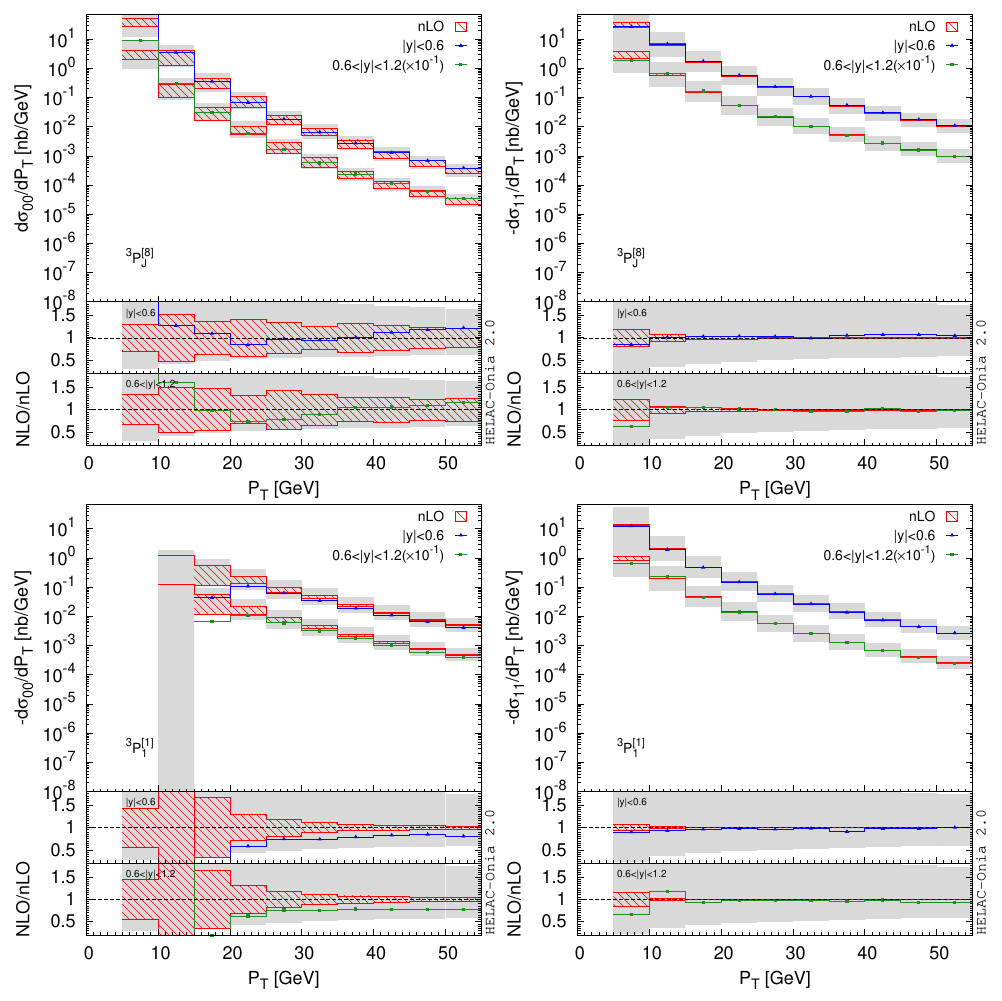
Figure 22 . Comparisons of spin-dependent differential cross sections for the 3 Fock states 3 P [8] between our nLO calculations and the complete NLO calculations. They are similar to figure